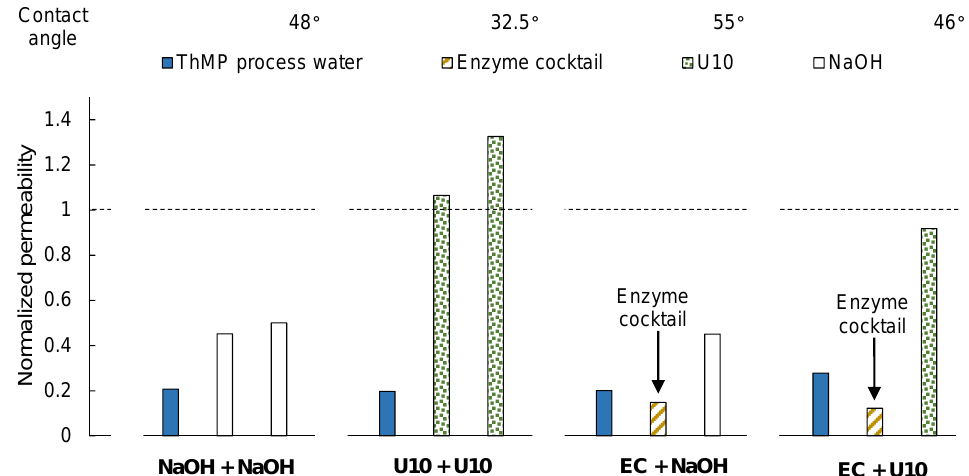
Figure 1. Normalized membrane permeability after fouling with ThMP process water and subsequent two-step cleaning. The water contact angles of the cleaned membrane samples are given above the figure. U10: Ultrasil 10, EC: Enzyme cocktail.